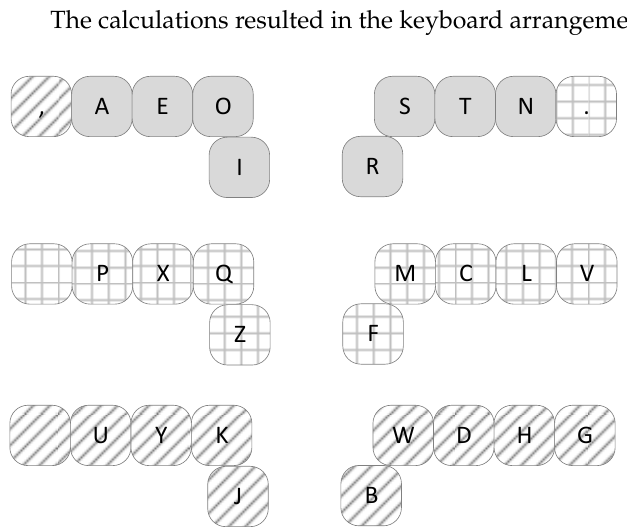
Figure 7. P-VX-ORK+ arrangement.